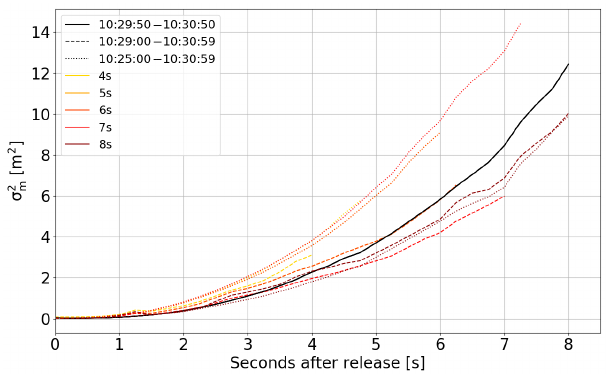
Figure 12. Meandering in the vertical. The black curve shows the ensemble average over the six puffs. The meandering is sensitive to the chosen ensemble. The coloured dashed and dotted curves show the meandering calculated for different numbers of puffs, selected by varying the time interval (line style) and the minimum trajectory lengths